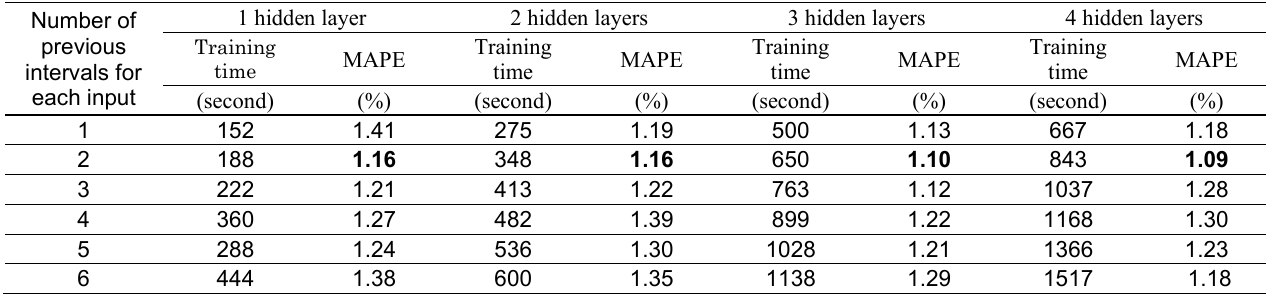
Table 2. Training time and testing result with different structure of LSTM